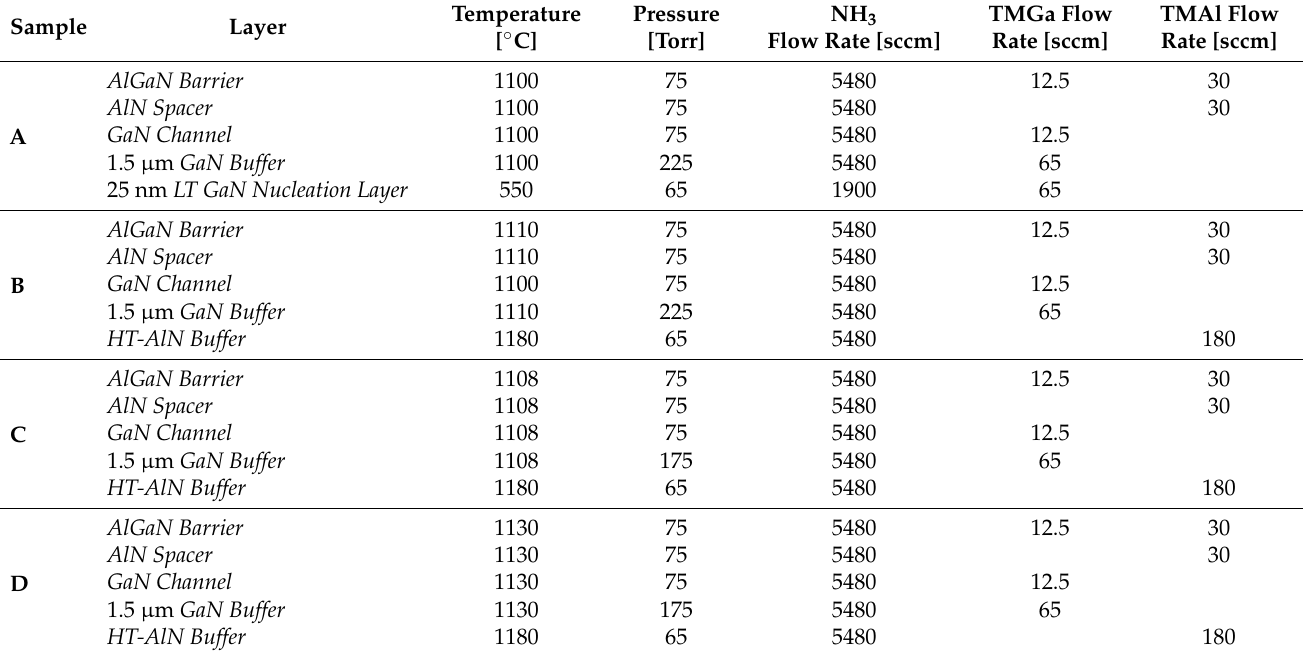
Table 1. The growth parameters of the four samples.